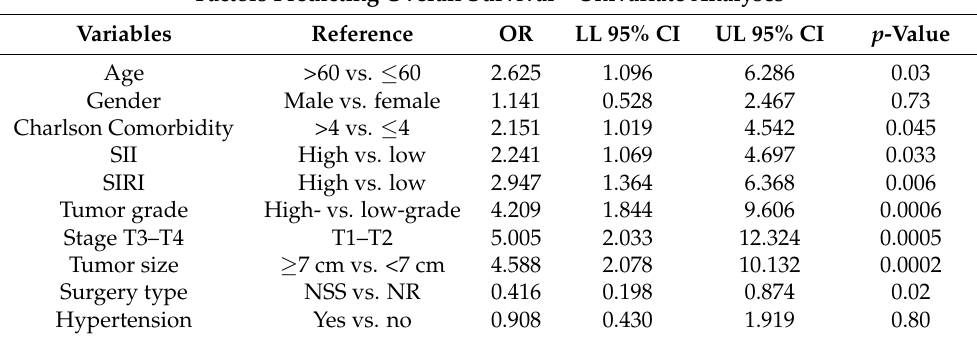
Table 4. Univariate analyses of factors predictive for overall survival in patients with clear cell renal cell carcinoma